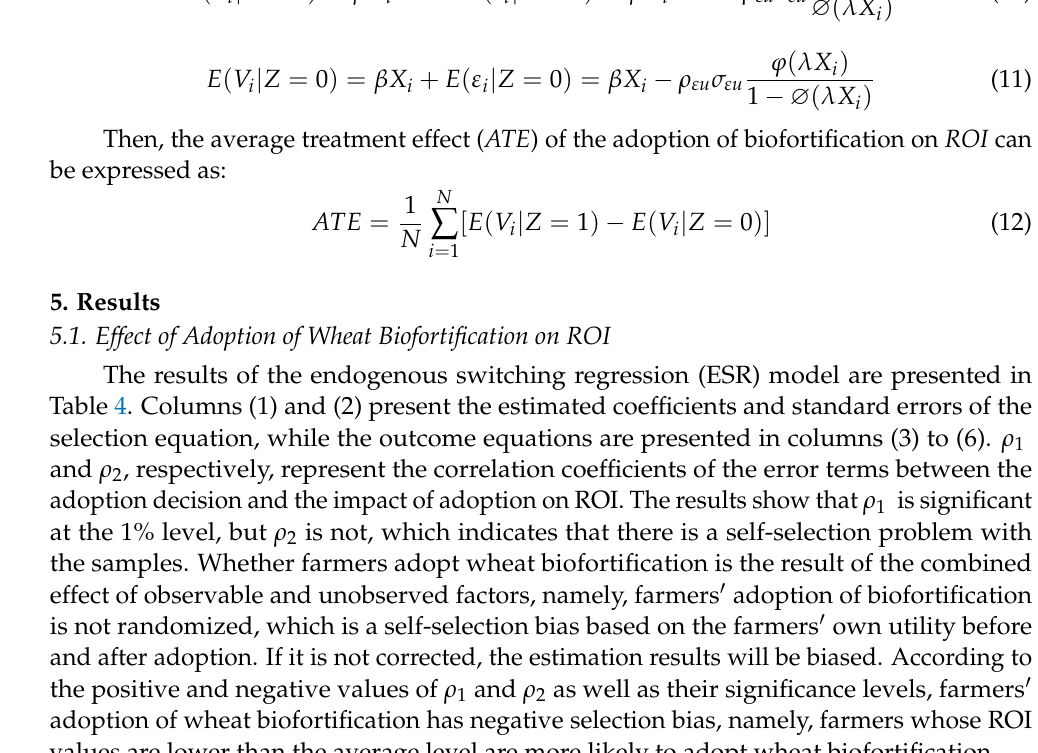
Table 4. Estimation results of ESR for adoption of biofortification and impact of adoption on ROI.